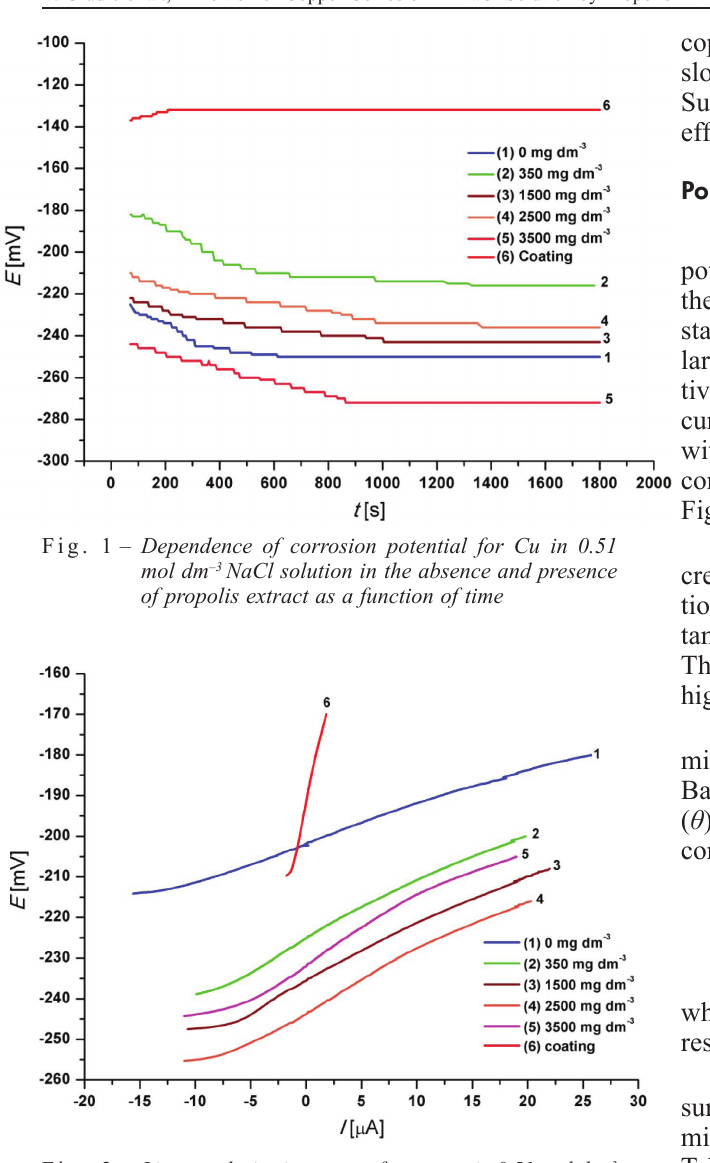
Fig. 2 – Linear polarization curves for copper in 0.51 mol dm –3 NaCl solution without stirring as a function of vari- ous propolis extract